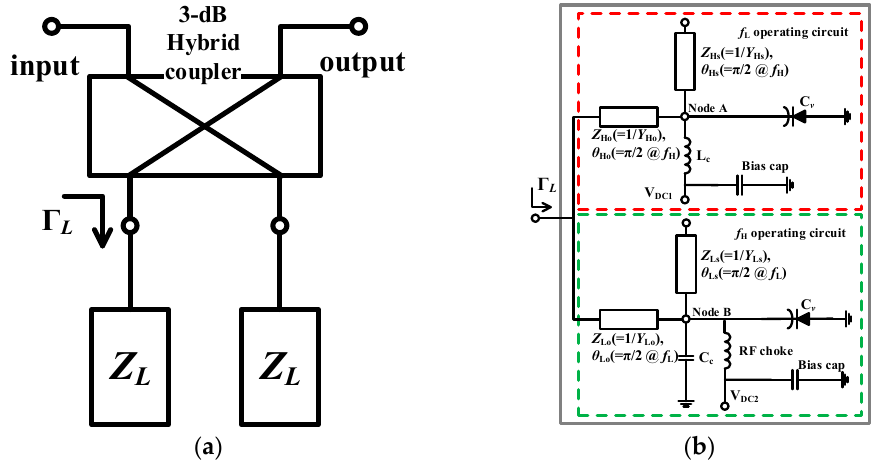
Figure 1. Structure of the proposed dual-band PS: ( a ) Overall two-port circuit using a 3-dB hybrid coupler and reflection loads; ( b ) One-port reflection load.